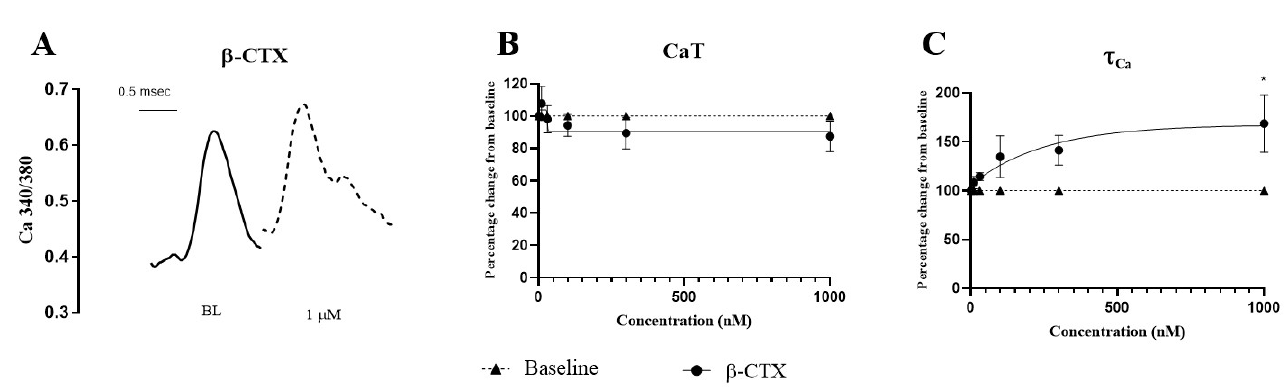
Figure 5. Impact of β-CTX on isolated cardiomyocyte calcium homeostasis. (A) Original recording of the intracellular calcium transient in an isolated cardiac myocyte before (BL) and after application of β-CTX (1 µM). (B) Non-linear curve fits of normalized peak calcium transients (CaT) and (C) calcium decay rate (τ ). Data are represented as mean ± S.E.M. * p < 0.05 vs Ca